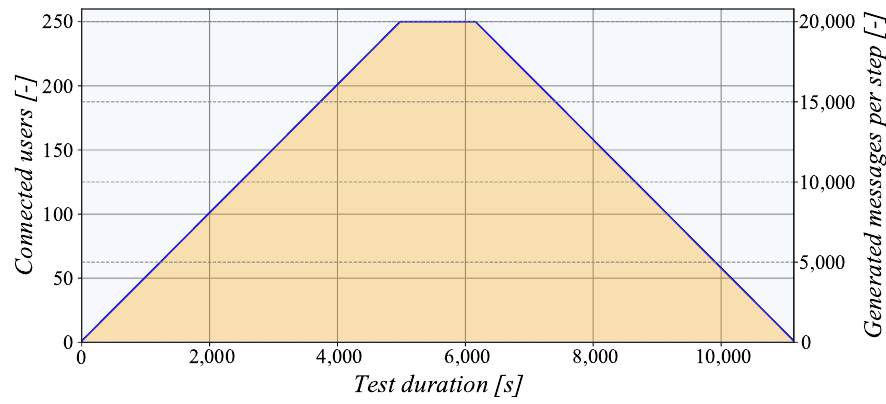
Figure 9. The progression of the number of messages generated in each step.